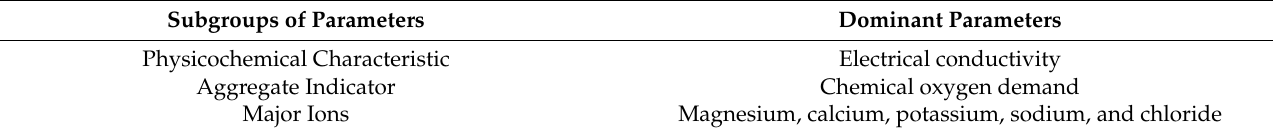
Table 7. Dominant parameters from final PCA analysis.